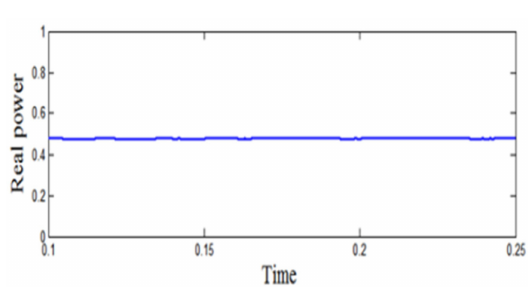
Figure 30. Reactive power from generation.